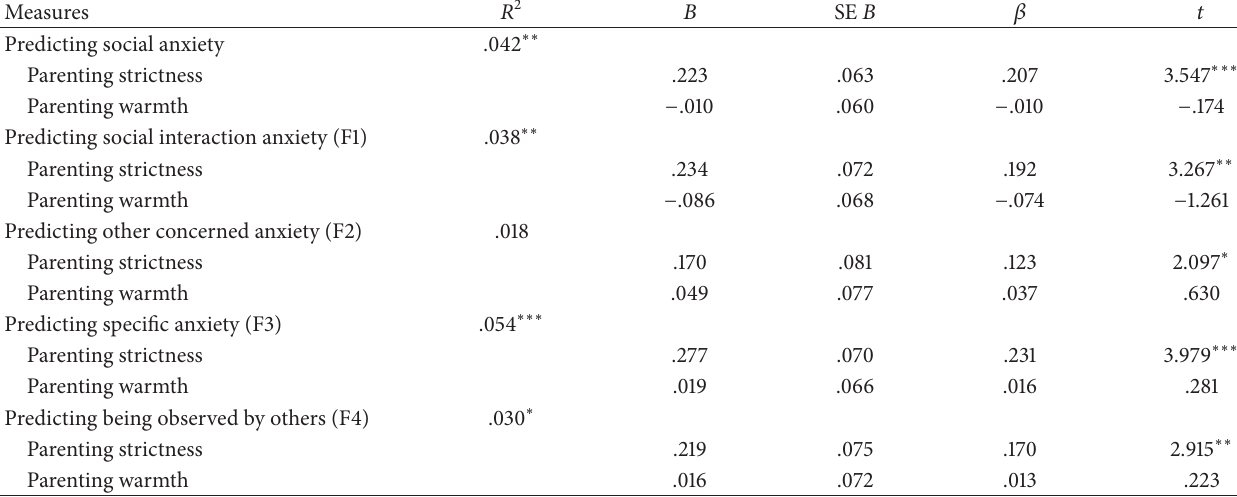
Table 4: Specificity of factors of parenting in predicting social anxiety and its four factors.